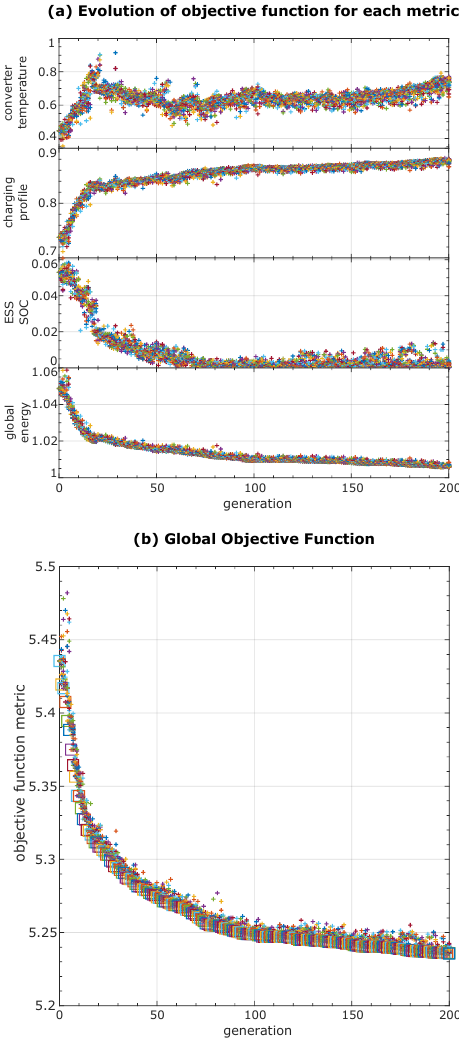
Figure 11. Evaluation of objective function: (a) Individual evaluation of each metric for all generations; (b) Global objective function as dependent of the